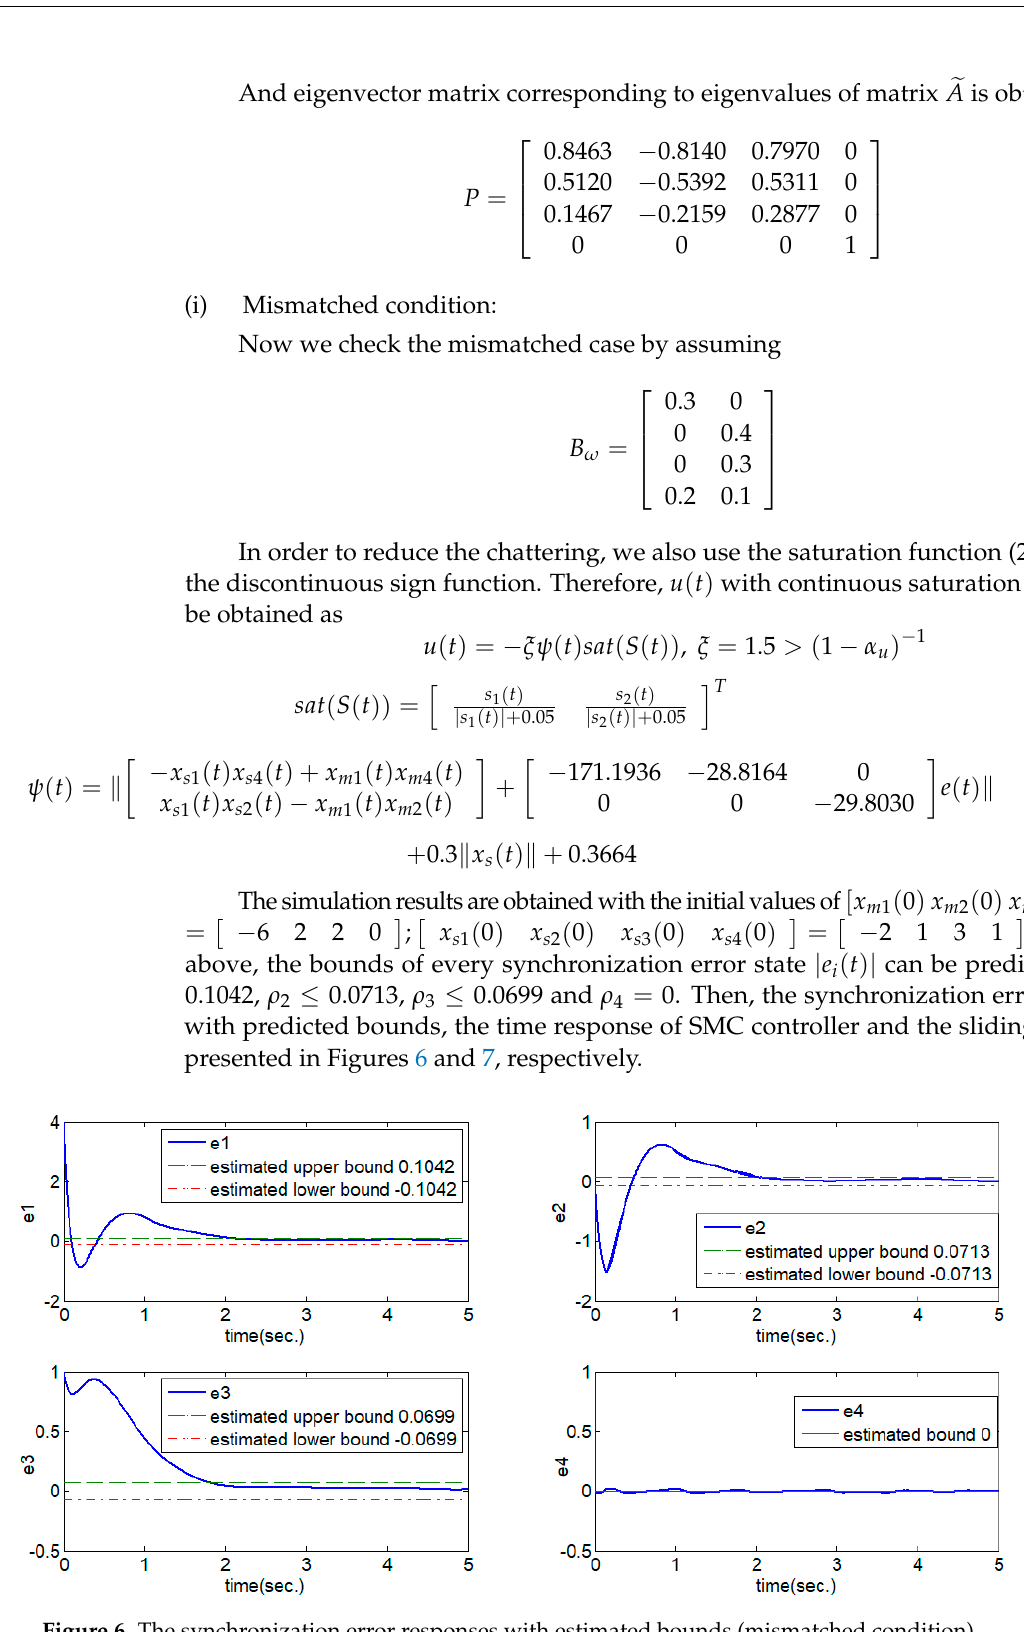
Figure 6. The synchronization error responses with estimated bounds (mismatched condition).